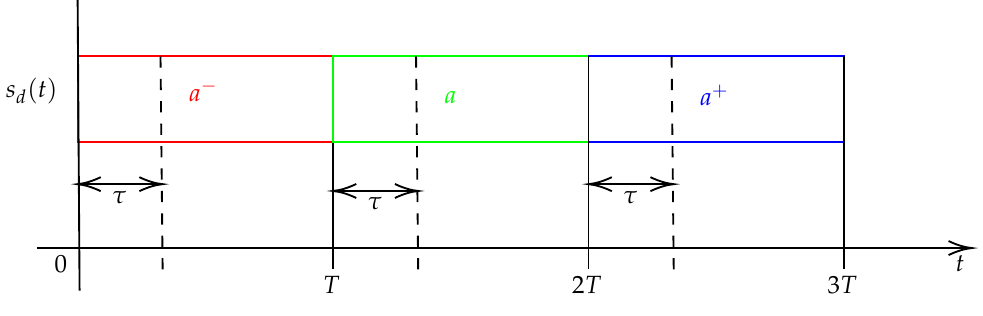
Figure 5. Illustration of the STO